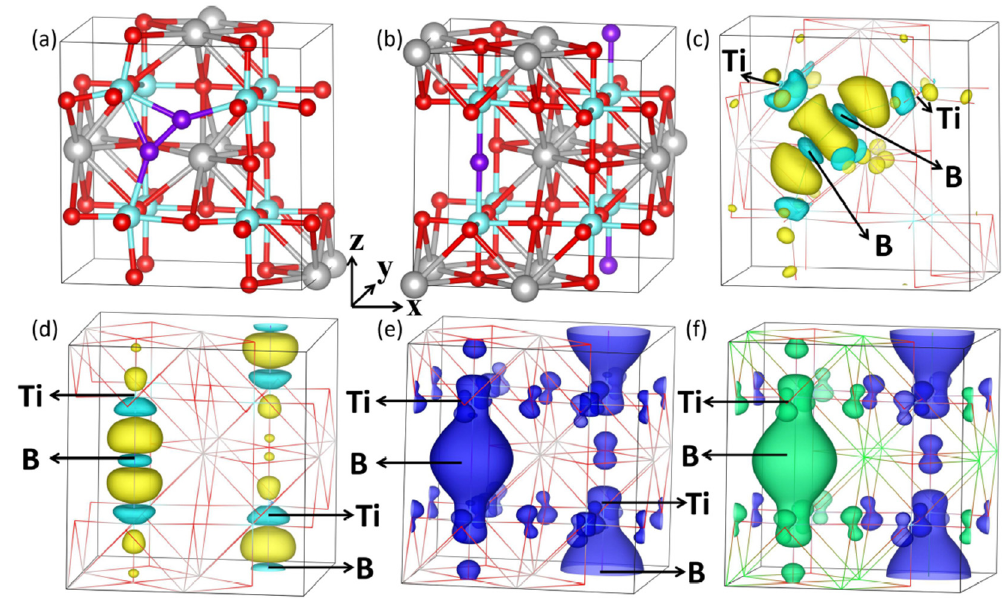
Figure 3. The relationship among bent Ti-B-Ti bond angle, O-Ti-O bond angle and change in MM (in the FM state), i.e., ∆ (Ti-B-Ti), ∆ (O-Ti-O), and ∆ MM, for different (0,j) structure, where ∠ Ti-B-Ti = ∠ O-Ti-O = 180° and the maximum MM (4.40 μ B ) under FM alignment among all configurations are taken as references. The values of ∆ MM are amplified five times for clarity.